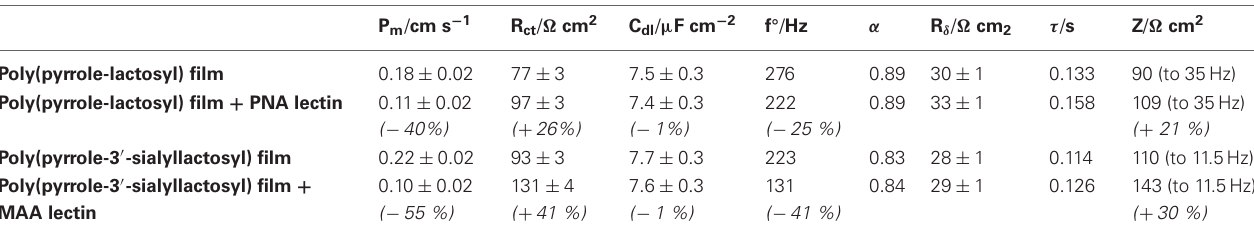
Table 1 | Permeability, values of equivalent circuit elements obtained for fitting of the experimental data and impedance modulus at 35Hz for poly(pyrrole-lactosyl) and at 11.5Hz for poly(pyrrole-3 (cid:2) sialyllactosyl).